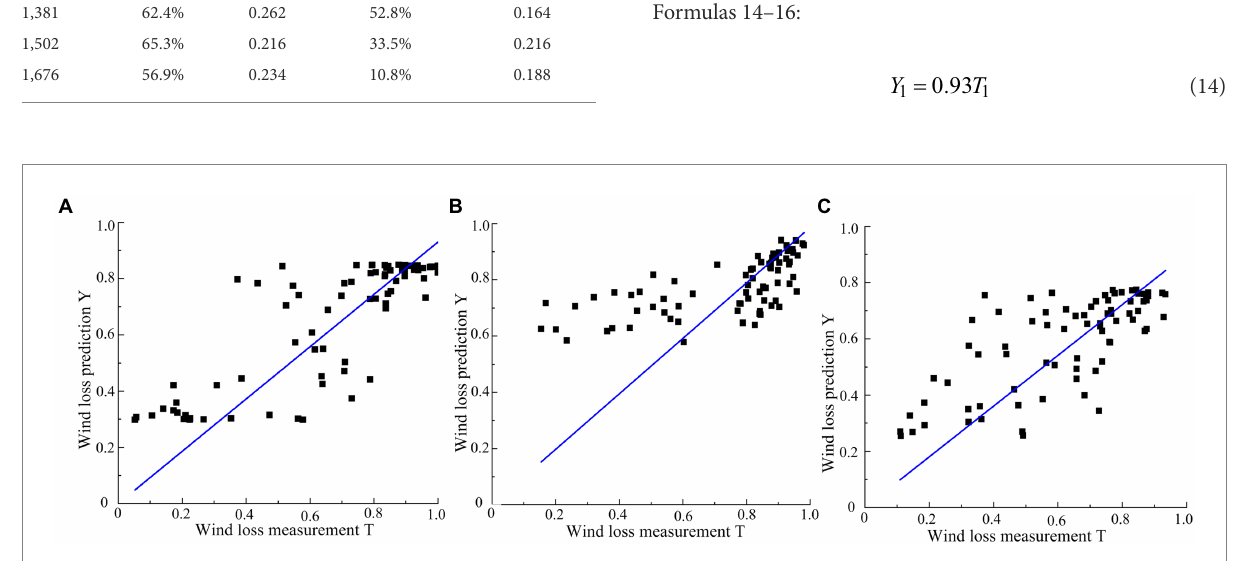
FIGURE 8 BP neural network training model measurement accuracy based on different conditions. (A) 1381 r/min. (B) 1502 r/min. (C) 1671